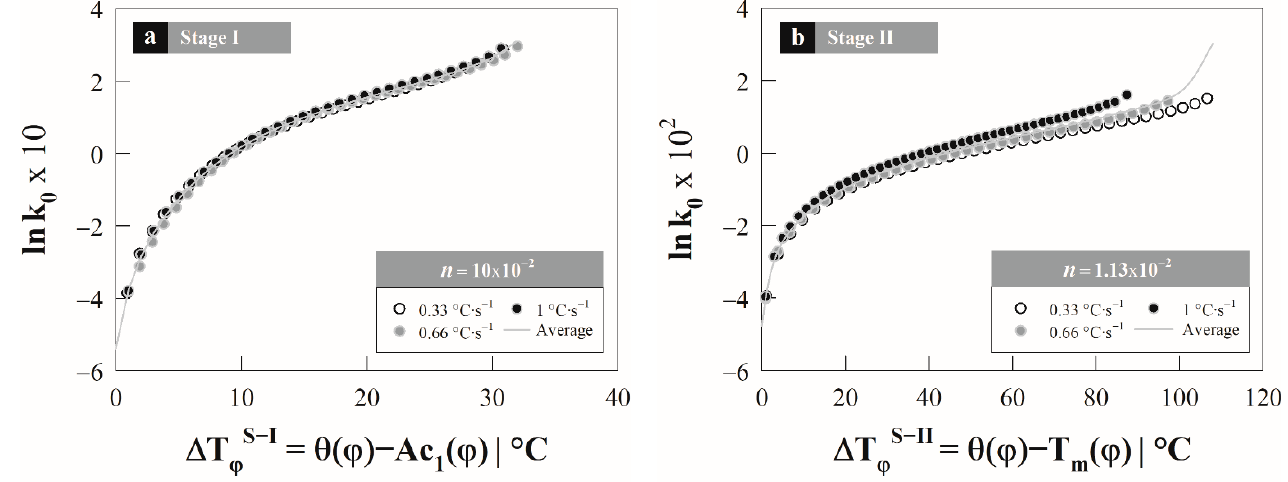
Figure 7. Behavior of the kinetic parameter ln k 0 as a function of the heating rate by austenite formation stages: ( a ) stage–I and ( b ) stage–II.